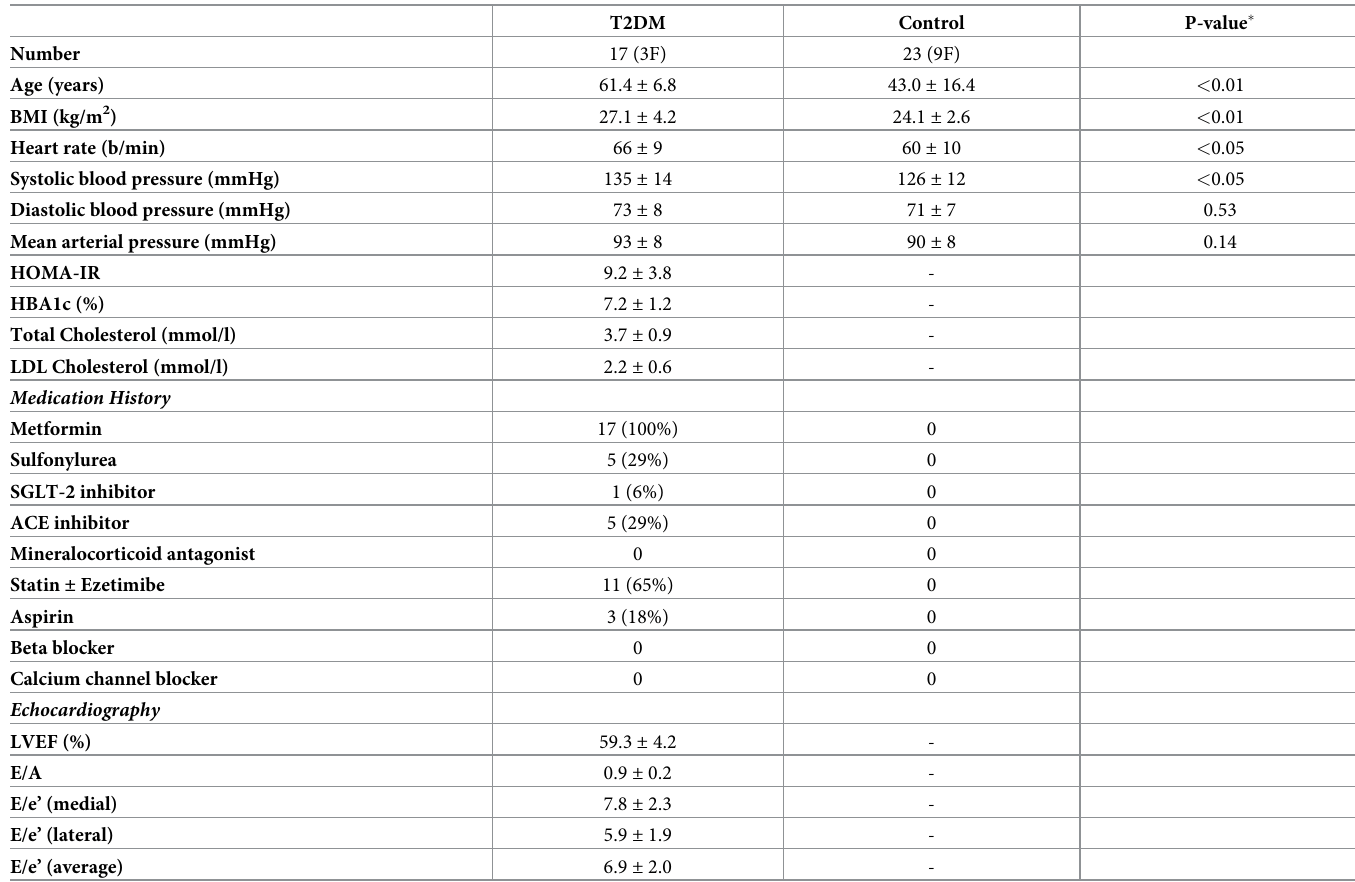
Table 1. Details on the study population characteristics and demographics